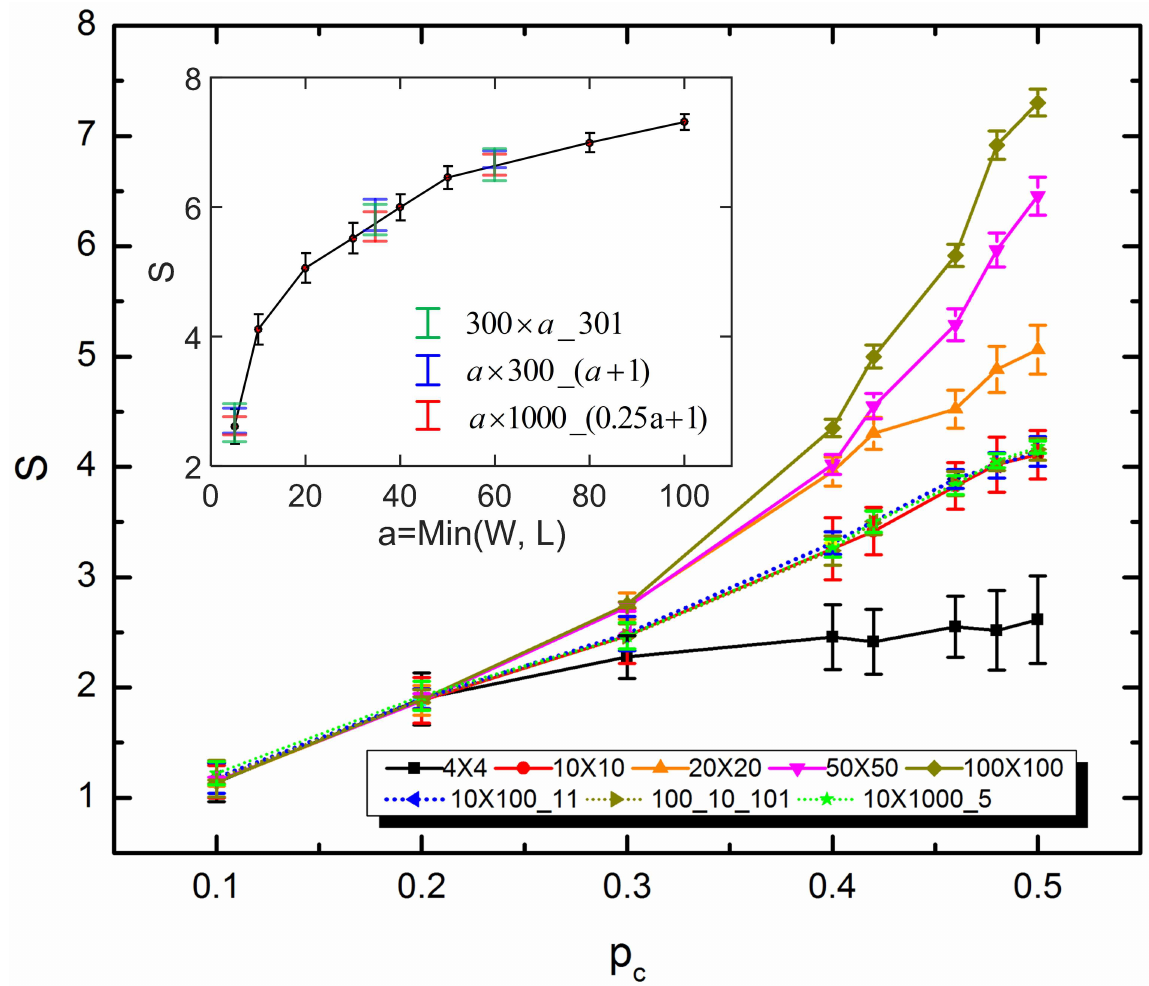
Fig 5. Dependence of the emergent region span on network size and electrode dimension. The results for square networks are shown by solid lines with error bars obtainedacross ten simulations for each point. Results of rectangularnetworks(10 × 100_11, 100 × 10_101and 10 × 1000_5)are presented by dashed lines. The inset compares the spans of different-sized square networkswith p c = 0.5 with those of rectangular networks with various network